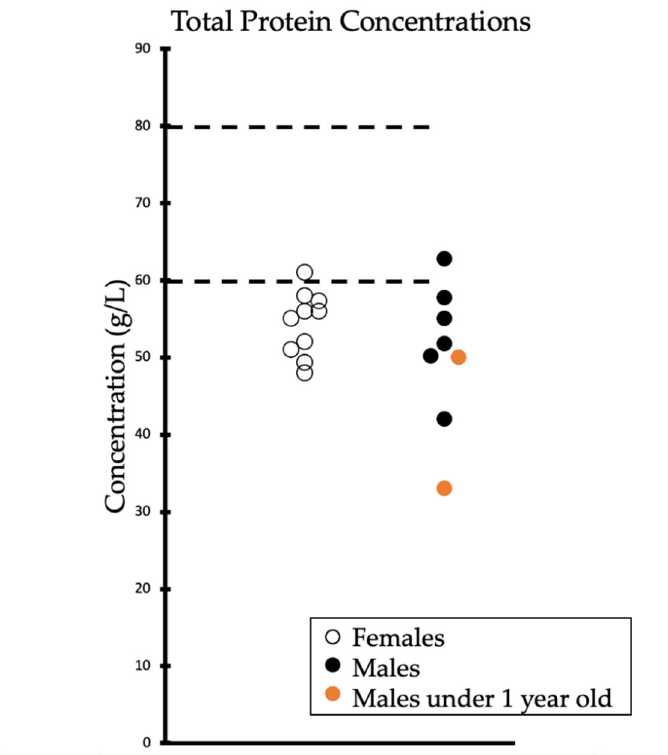
Figure 2. Total plasma protein concentration in CAA patients. Each data point represents the total plasma protein concentration measured in an individual with CAA. The filled circle and the unfilled circle represent males and females, respectively. The typical reference range for individuals older than 1 year of age are provided by the dashed lines (60–80 g/L). The orange data points represent the two patients who were younger than one year of age; both of these patients were male.